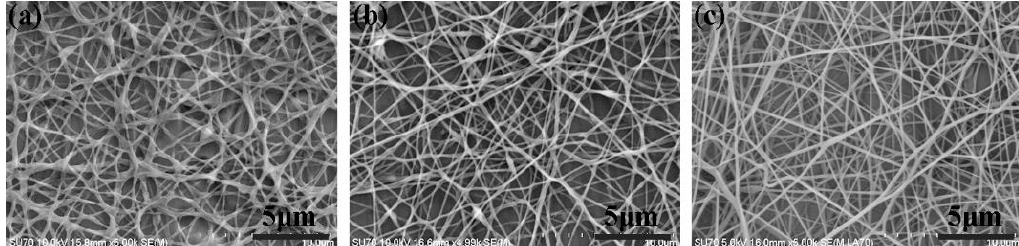
Figure 2. Scanning electron microscope (SEM) images of deposited nanofibers with different solution concentrations. ( a ) 8 wt %; ( b ) 10 wt %; ( c ) 12 wt %. The applied voltage, the flow rate, and the distance between the spinneret and the collector were 20 kV, 300 μL/ h, and 15 cm, respectively.